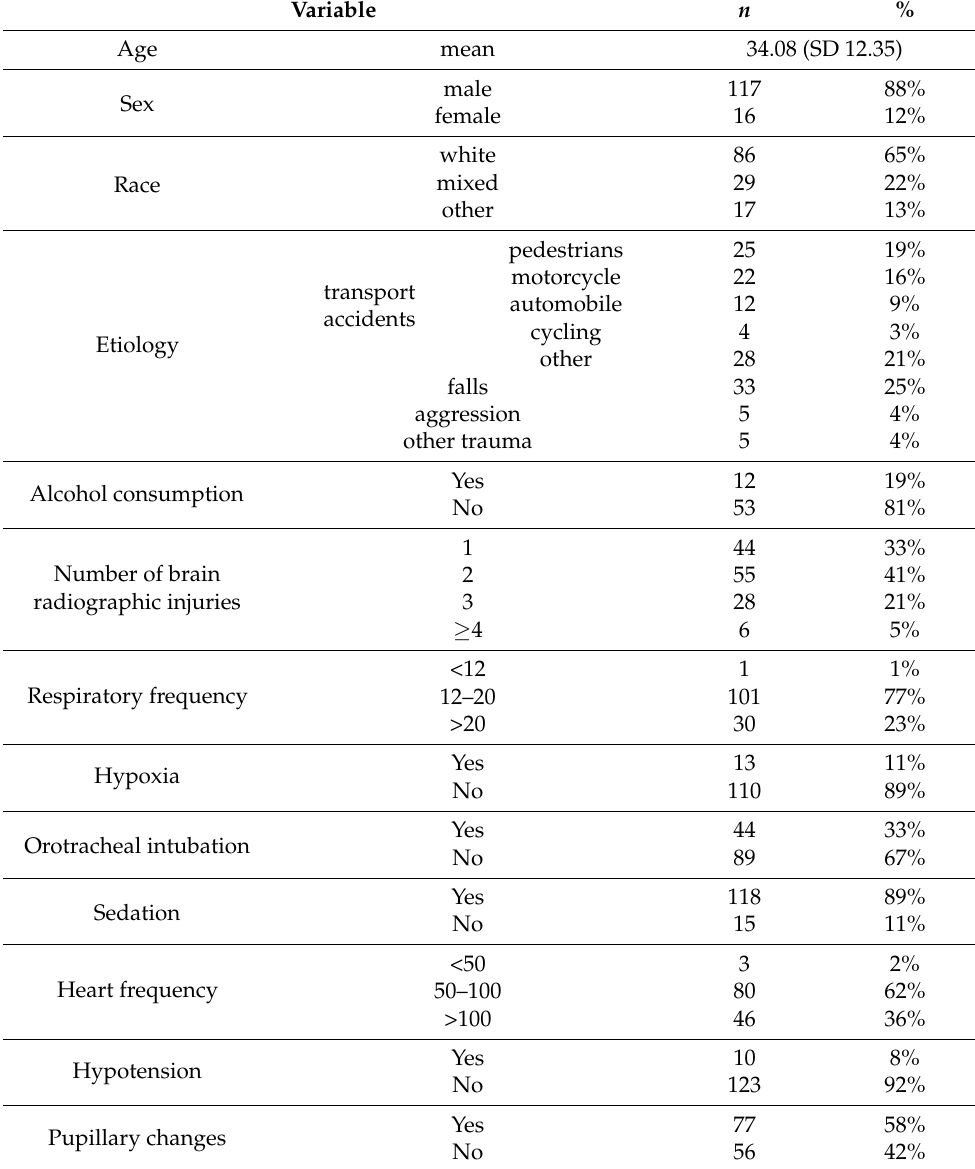
Table 1. Demographic data for patients at